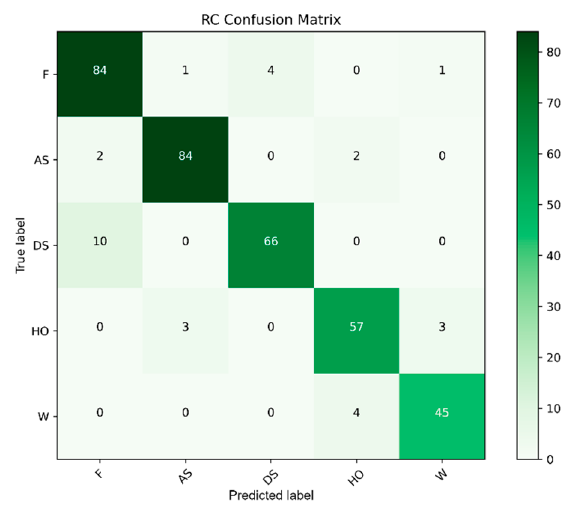
Figure 17. Confusion matrix (RC classifer).